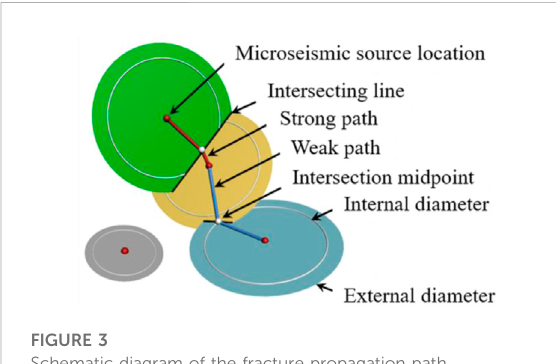
FIGURE 3 Schematic diagram of the fracture propagation path.